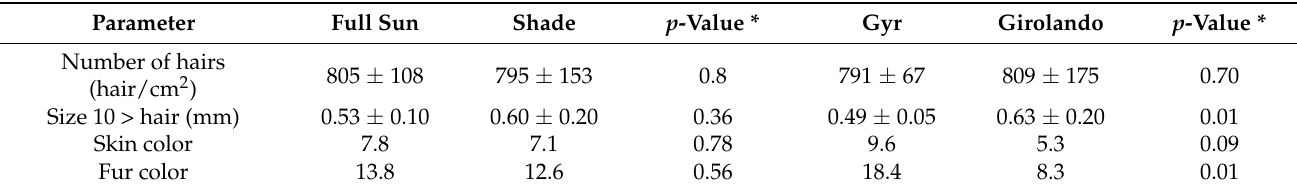
( p = 0.56) color were not different between environments. Gyr coat color (a = red color